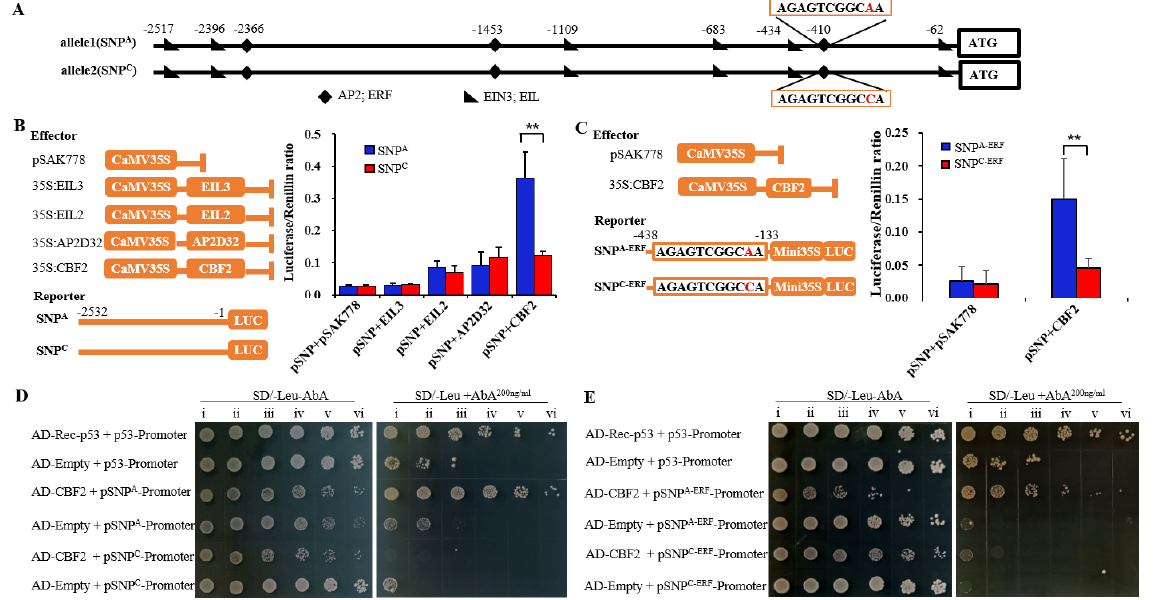
Figure 2. The SNP site in an ERF − binding element is differentially regulated by MdCBF2. ( A ) Cis-acting regulatory elements for AP2/ERF and EIN3/EIL transcription factors were identified in the MdPG1 promoter of “Huahong” using the Plantpan2.0 (http://plantpan2.itps.ncku.edu.tw, accessed on 1 June 2020). An SNP A/C site in an ERF-binding element was located 411 bp upstream of the start codon. ( B , C ) Dual-luciferase assays were carried by co-infiltration of Nicotiana benthamiana leaves with effector gene constructs (CaMV35S promoter driving no CDS or is driving the CDS of MdEIL2, MdEIL3, MdCBF2 or MdAP2D32) and reporter gene constructs (2.5 kb with SNP A or SNP C , and 0.3 kb plus minimal CaMV 35S with SNP A or SNP C fused to the LUC coding sequence). The error bars are standard deviations of the mean from six repeats. Asterisks indicate significant differences by t -test: ** p < 0.01. ( D , E ) Yeast-one-hybrid assay showed that MdCBF2 specifically bound to 2.5 kb ( D ) and 0.3 kb ( E ) promoter sequence of MdPG1 allele containing the SNP A within the ERF-binding element. Yeast cells co-transformed with the constructs named on the left were cultured on non- selective medium SD/-Leu/-AbA (left panel) and selective medium SD/-Leu/+AbA 200 ng/mL (right panel), in a dilution series of 5 0 , 5 − 1 ,5 − 2 , 5 − 3 , 5 − 4 , and 5 − 5 (i–vi). Rec-p53 and the p53-promoter were used as positive controls. The empty vector and the promoter fragments of MdPG1 were used as negative